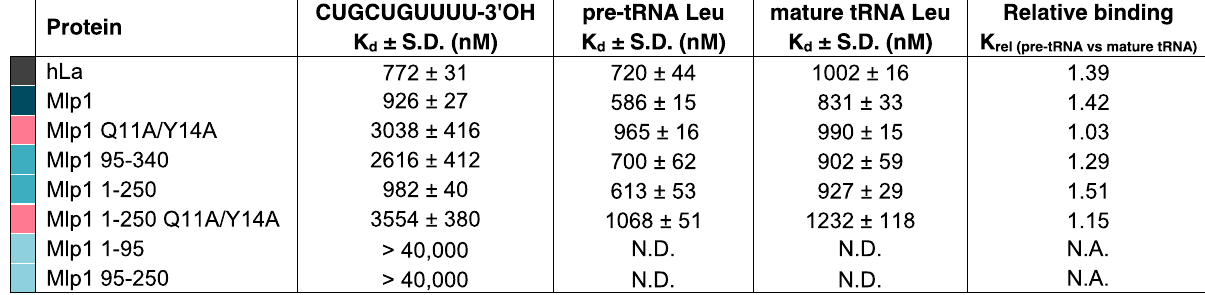
Table 1 | K d values from EMSAs determining binding of hLa, Mlp1, and Mlp1 mutants to typical La protein – RNA